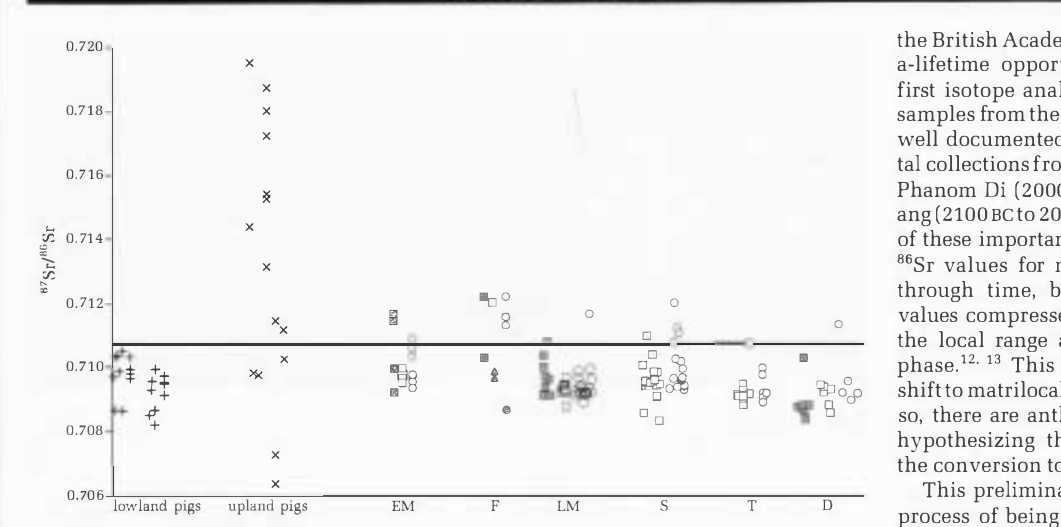
Figure 4 Summary of87Sr/86Sr in human tooth enamel from Neolithic Germany: o =female, D =male, 6 =sex unknown,+ = pig (used to map values). Filled (grey) sym­ bols are burials with a shoe-last adze. Sites ordered chronologically, from the earliest at the left, include Early Miilhausen (EM}, Flomborn (F), Late Miilhausen (LM}, Schwetz­ ingen (S}, Talheim (T), and Dillingen (D). 87Sr/86Sr above about 0.71 OB (horizontal line) indicates significant diet from the uplands.